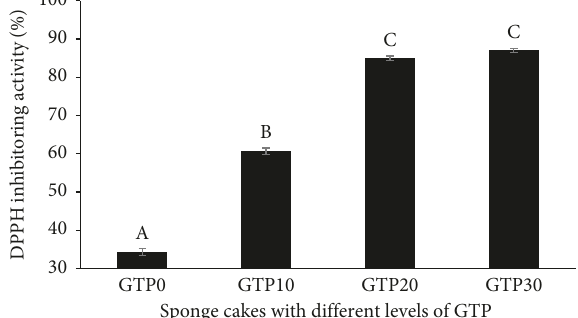
Figure 1: The antioxidant activity of cake samples with different GTP